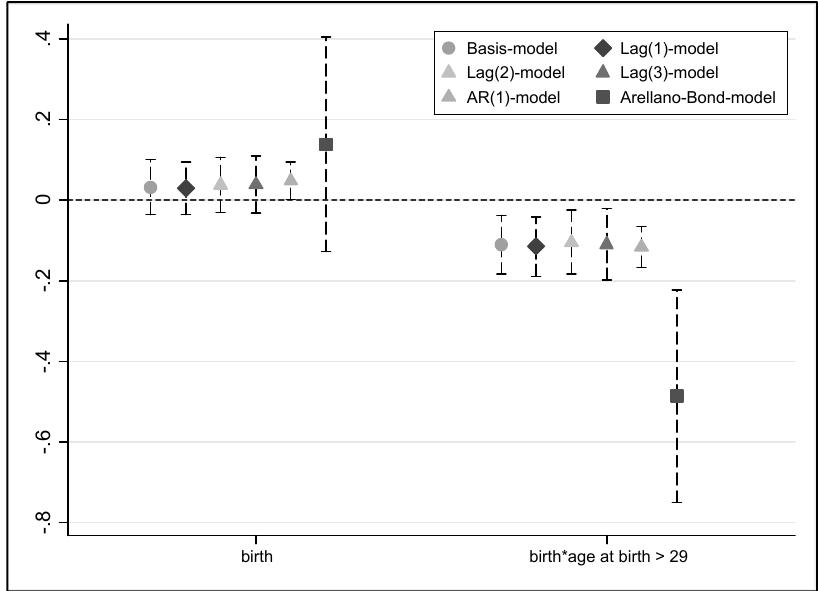
Figure 3 : Results of the sensitivity analyses based on the age at first birth (binary) ‒ point-estimations and 95%-confidence